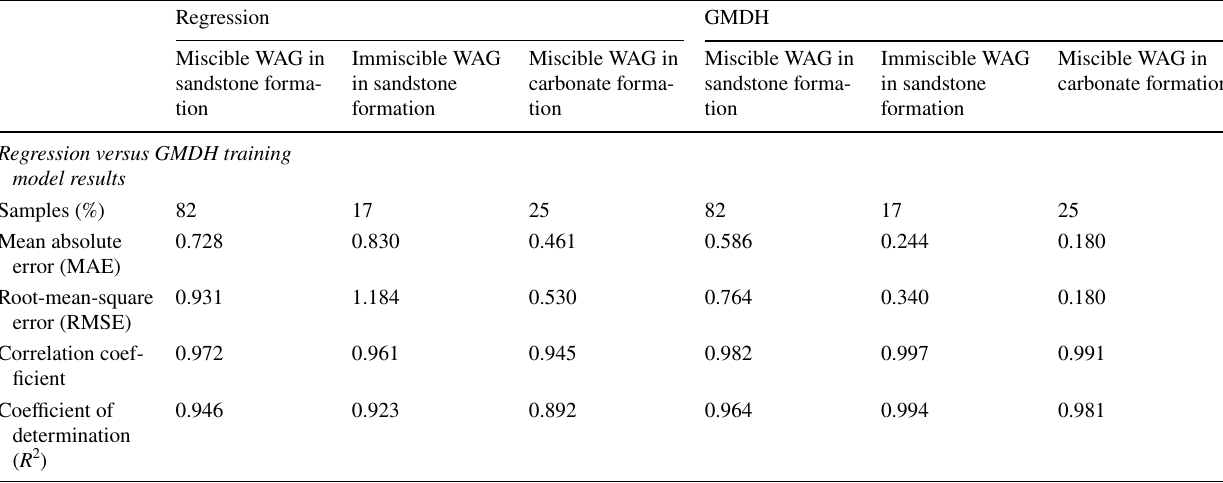
Table 6 Summary of the two prediction model results: training set